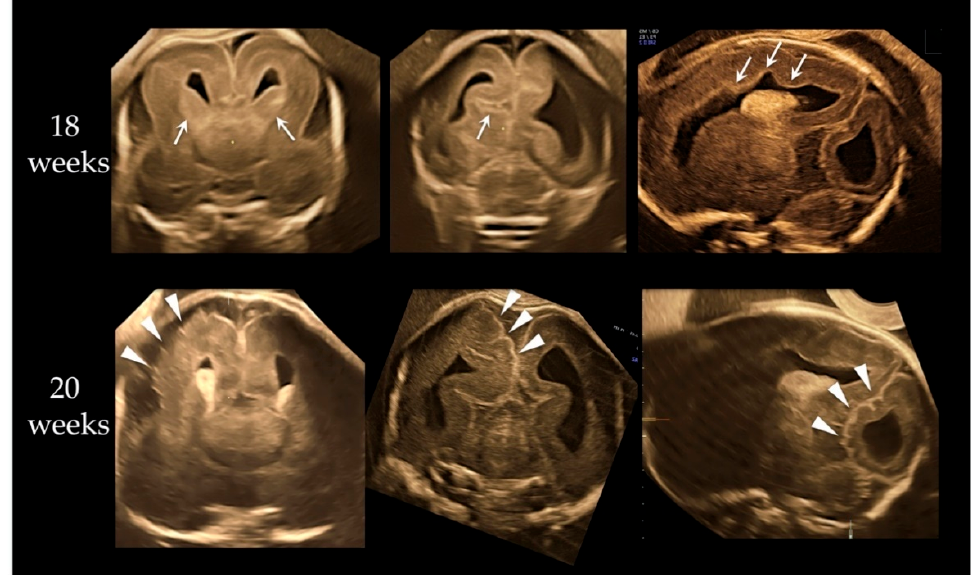
Figure 1. Neurosonographic findings at 18 and 20 weeks of gestation. Upper three images are at 18 weeks. From left, anterior coronal, posterior coronal, and parasagittal views. Megalencephaly with asymmetrical structure, broad ganglionic eminence (arrows on upper left image), abnormal sulcation (arrow on upper-middle image) on cerebral cortex, and irregular ventricular wall (arrows on upper right image) were demonstrated. Lower three images are at 20 weeks. From left, anterior coronal, posterior coronal, and parasagittal views. A remarkable cortical malformation with multifocal polygyria (arrowheads) was visualized; polygyria were not seen at 18 weeks. Compared to upper images, taken two weeks before, focal cortical dysplasia due to rapid neuronal migration disorder may have occurred randomly in various cerebral cortex regions.